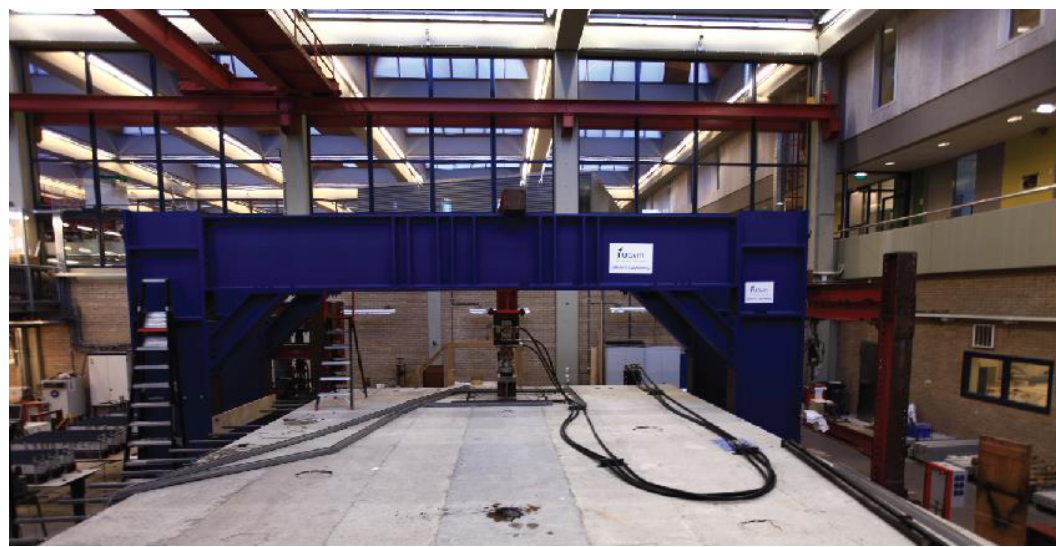
Figure 5. Overview of the test setup, showing setup 1 with the new middle deck.